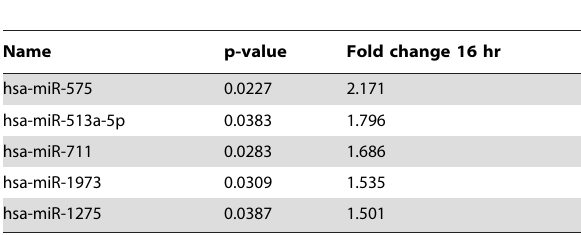
Table 5. Differentially expressed miRNA species in H9 hESC